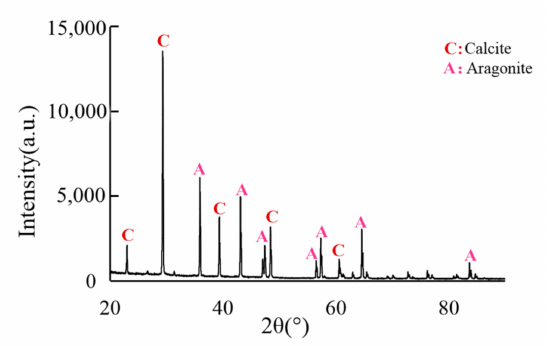
Figure 5. XRD diffraction pattern of crystal sample.